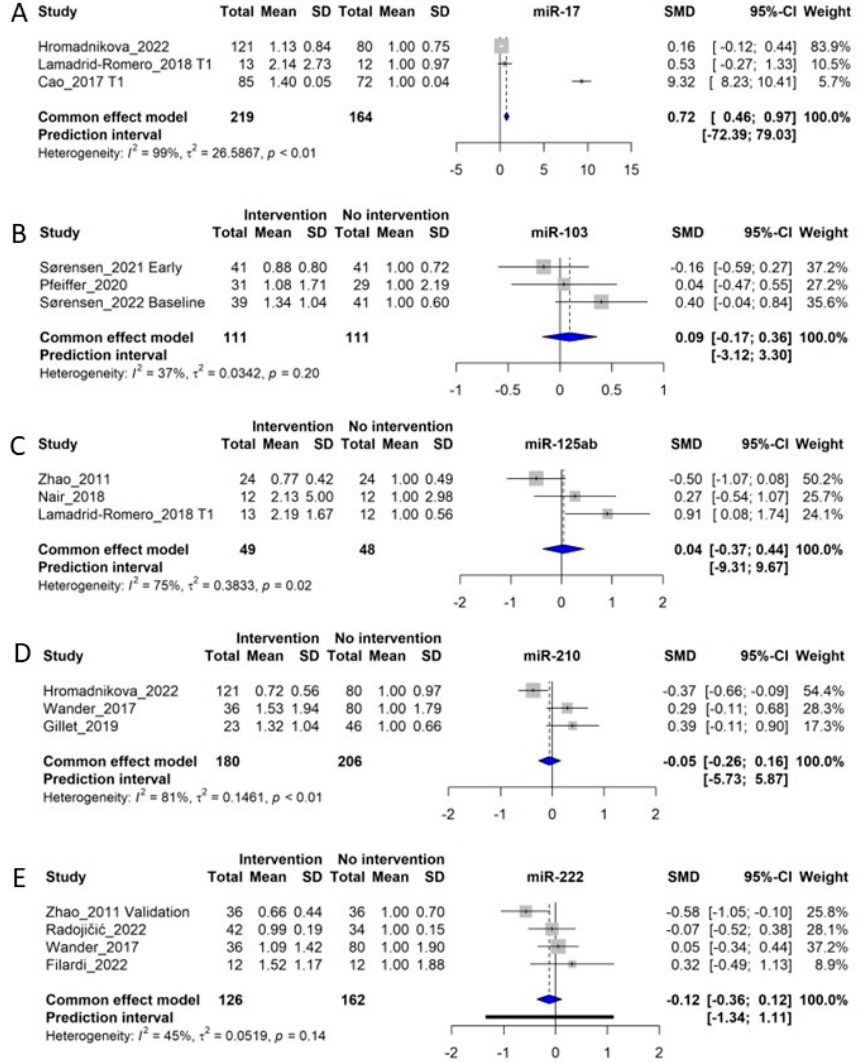
Figure 6. Forest plots of the fixed-effect meta-analysis of ( A ) miR-17 [30,33,37], ( B ) miR-103 [16,20,21], ( C ) miR-125a/b [18,37,52], ( D ) miR-210 [28,33,41], and ( E ) miR-222 [18,28,29,51].